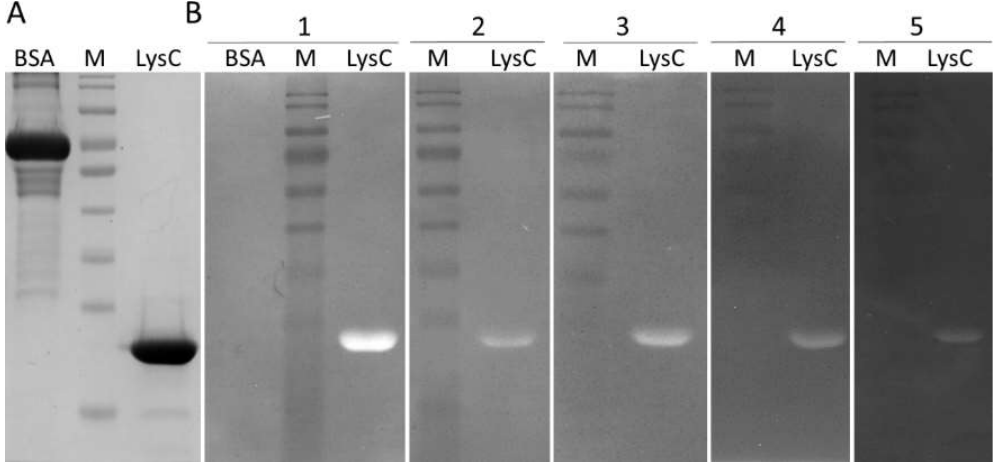
Figure 2. The SDS-PAGE profile and zymogram analysis of the lytic activity of LysC. (A) SDS-PAGE (12.5%) of 1 µ g of bovine serum albumin (BSA) and purified LysC; (B) Zymogram analysis showing lytic activity of LysC against ( 1 ) C. intestinale DSM 6191, ( 2 ) C. sporogenes DSM 767, ( 3 ) B. cereus ATCC 13061, ( 4 ) M. luteus ATCC 4698, and ( 5 ) S. aureus ATCC 25923; BSA in panel 1 served as a negative control; Lytic activity of LysC is indicated by a single cleared band. M: PageRuler pre-stained protein ladder, 10 to 180 kDa (Thermo Fisher Scientific).